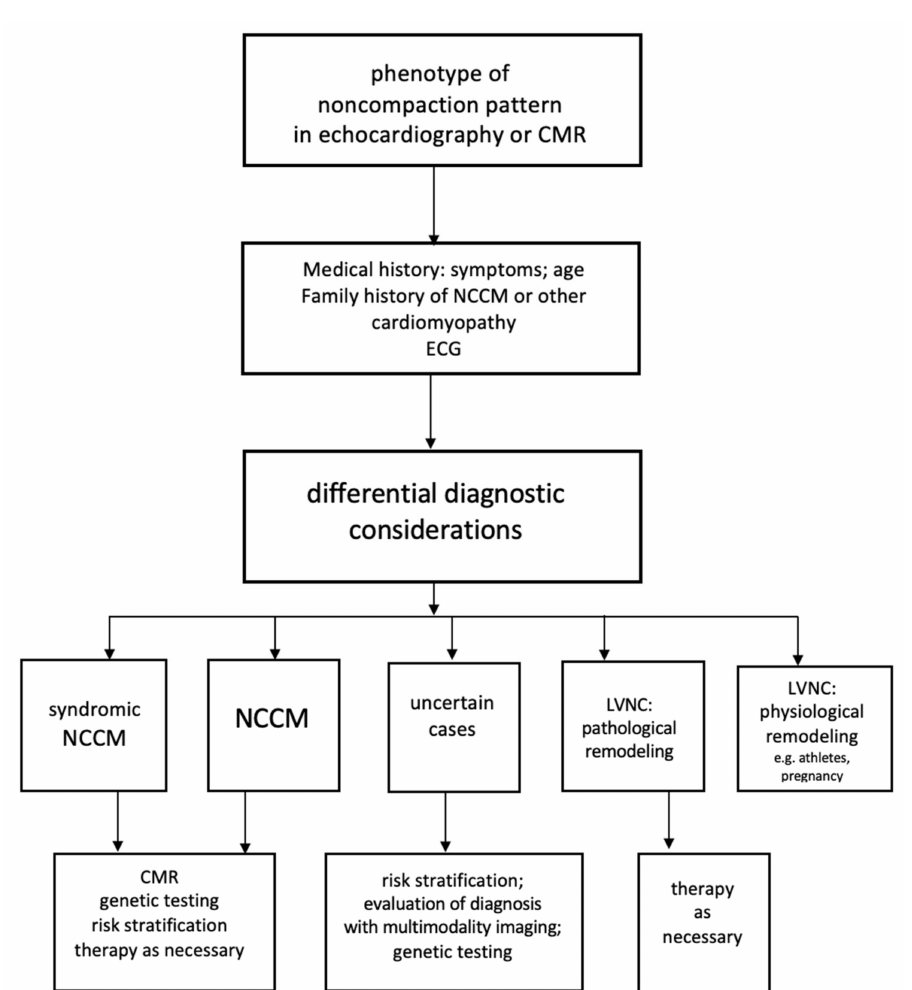
Figure 4. A pathway for differential diagnosis and risk stratification in patients with noncompacted myocardium